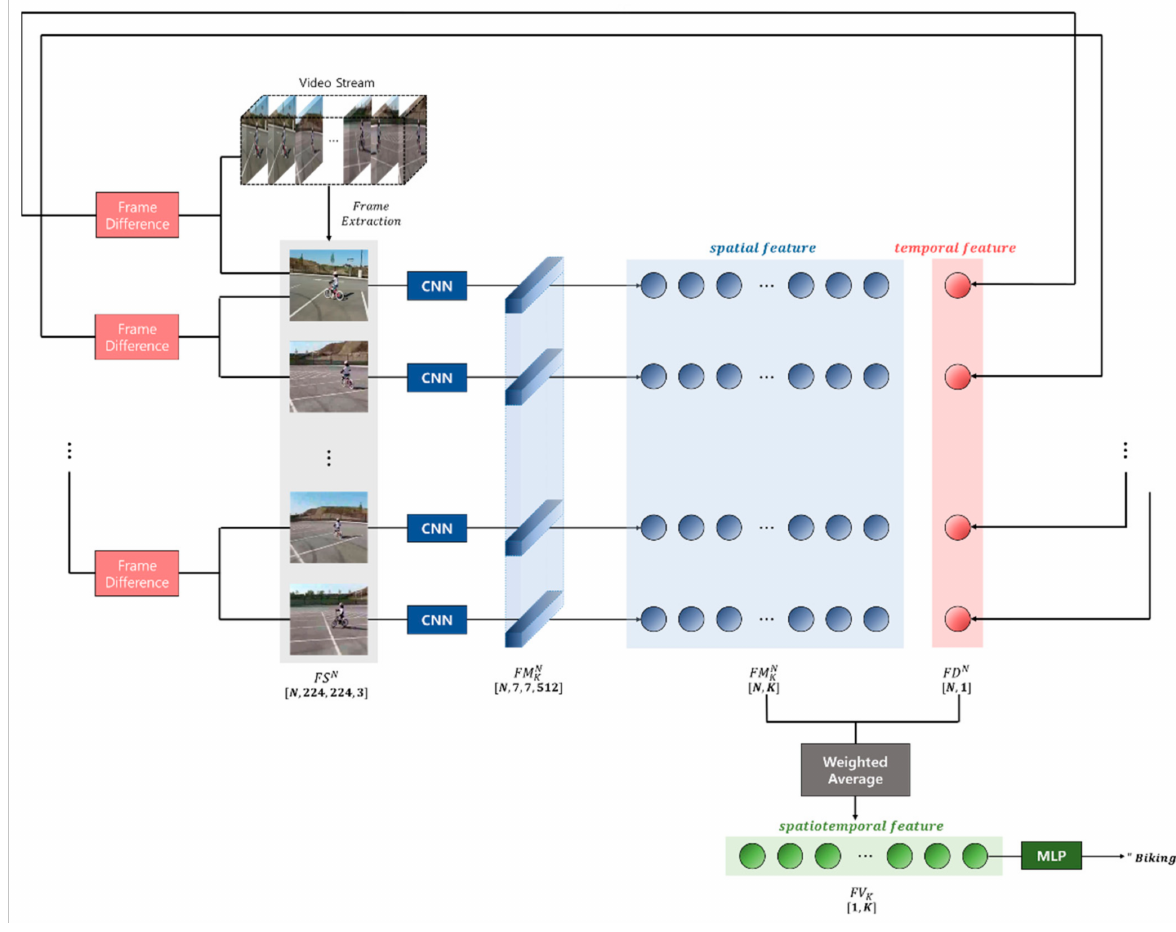
Figure 3. Action recognition process of the proposed